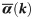
Average risk attitude α¯(k) in the rational market under variable taxation schemes.